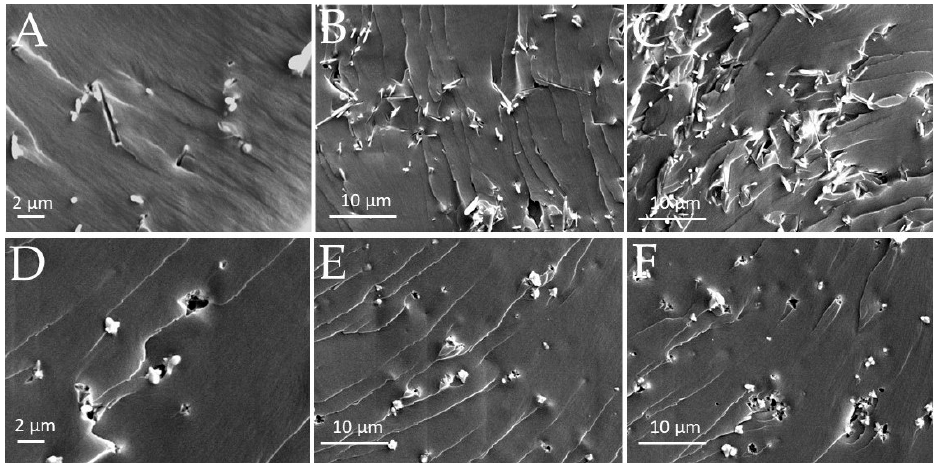
Figure 9. Typical SEM micrographs of fracture surfaces of EB/ZFL 96/4 ( A ), EB/ZFL 90/10 ( B ), EB/ZFL 80/20 ( C ), EB/ZLN 96/4 ( D ), EB/ZLN 90/10 ( E ), and EB/ZLN 80/20 ( F ).